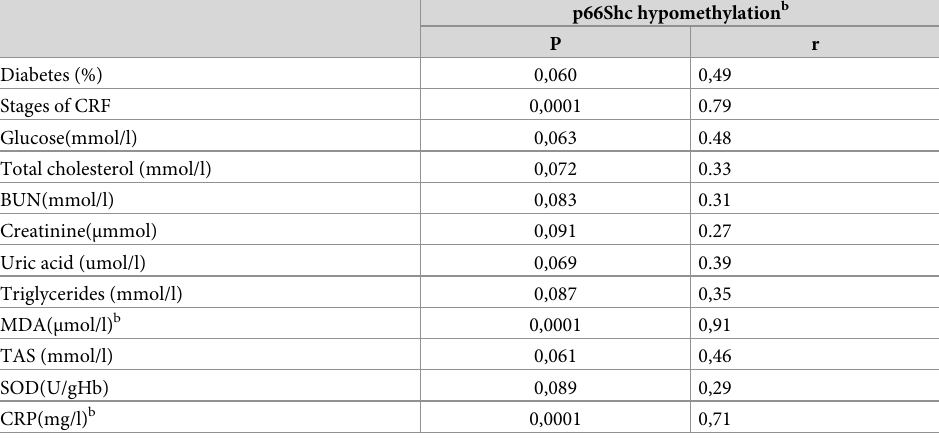
Table 5. Correlation between p66Shc DNA hypomethylation with clinical characteristics, inflammation and oxi- dative stress biomarkers in CRF patients by multiple analyses.